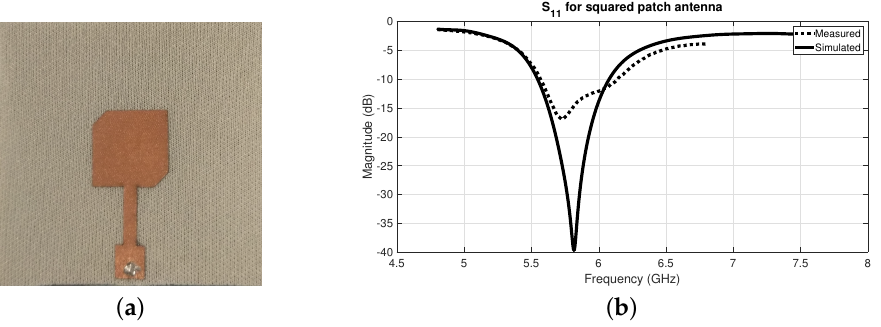
Figure 13. Squared patch textile antenna for 5.8 GHz: ( a ) manufactured antenna and ( b ) S 11